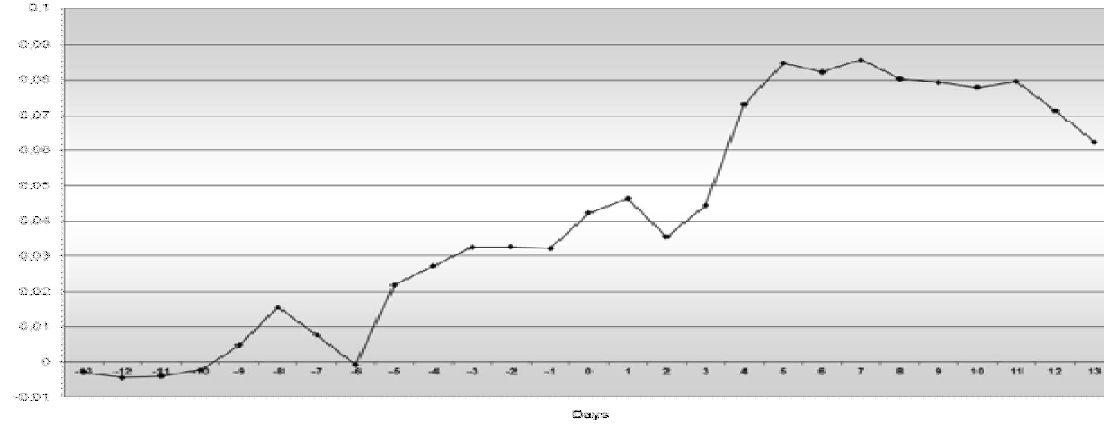
Fig. 6. Cumulated abnormal returns in the market model (normal stock